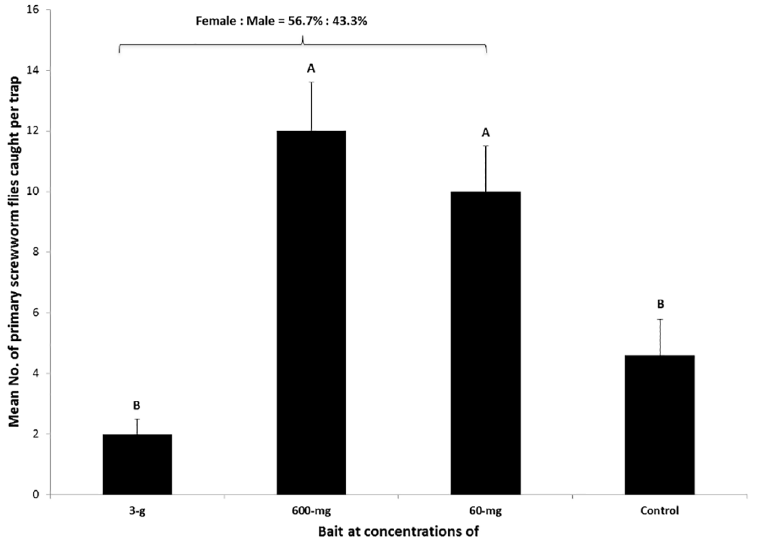
Fig 5. Mean number of primary screwworm flies (Means ± Std. Error) caught in traps baited with synthetic lures at dosage of 3 g, 600 mg and 60 mg. Different letters on top of bars indicatesignificant differences (ANOVA, followedby LSD, P <